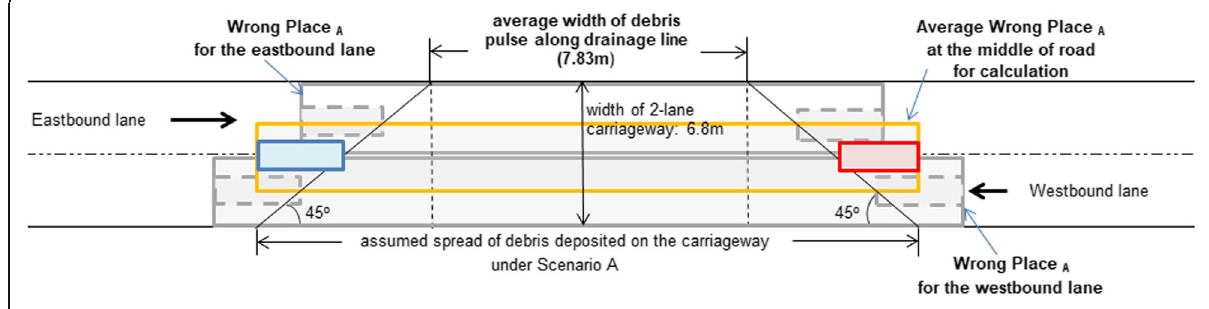
Fig. 10 Wrong Place A for Scenario